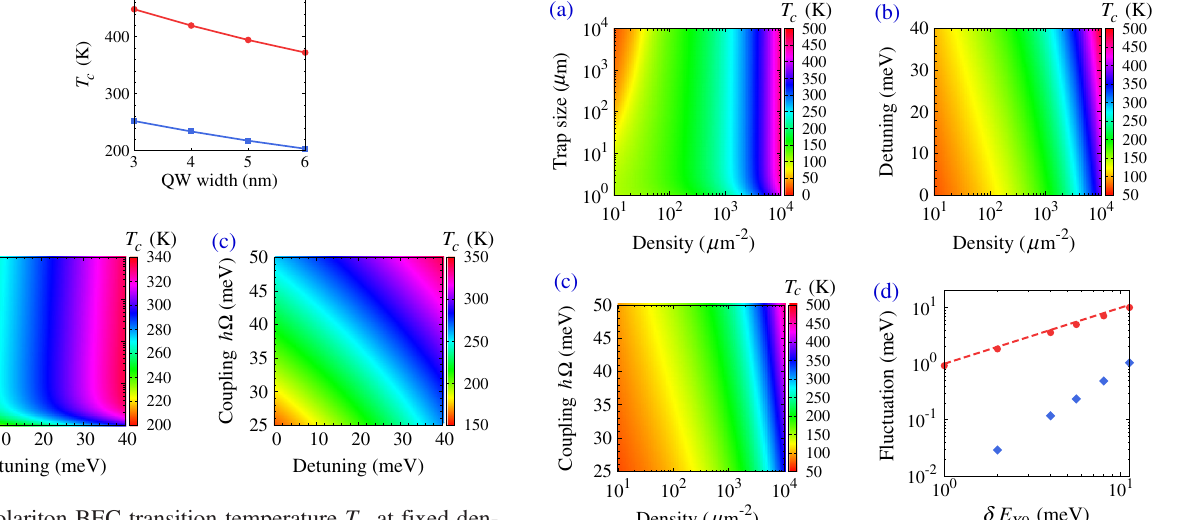
FIG. 5. Polariton BEC transition temperature T at fixed den- c sities.(a)Transitiontemperature T withdetuning Δ ¼ 30 meVfor c different QW widths (with QWs filling an entire active region) at FIG. 6. BEC transition temperature T as a function of total c fixedpolariton densities: 1 . 5 × 10 4 μ m − 2 (curvewithsolidcircles) polariton density and (a) box-trap size, (b) exciton-photon detuning, and (c) exciton-photon-coupling strength. (d) Root- and 1 . 9 × 10 3 μ m − 2 (curvewith solid squares). Forthe higher total Þ − 2 . For the mean-square deviation of the vacuum Rabi splitting (diamonds) density, the exciton density in each QW is below ð 9 a B and lower-polariton dispersion depth (circles) as a function of exciton inhomogeneous broadening δ E . In (a) and (b), the X 0 exciton-photon coupling is ℏ Ω ¼ 48 meV (QW width 4 nm and couplingis ℏ Ω ¼ 48 meV(QWwidth4nmandbarrierwidth5nm) barrier width 5 nm). For (a) and (c), the detuning is 30 meV. For (b) and (c), the exciton-box-trap size is 10 μ m. The exciton- ¼ 1 . 59 eV. For (d), the detuning is recombination energy is E transitiontemperature T onthedetuning Δ andtheexciton-photon c X 0 Δ ¼ 0 . The dashed curve in (d) depicts the value of δ E itself for X 0